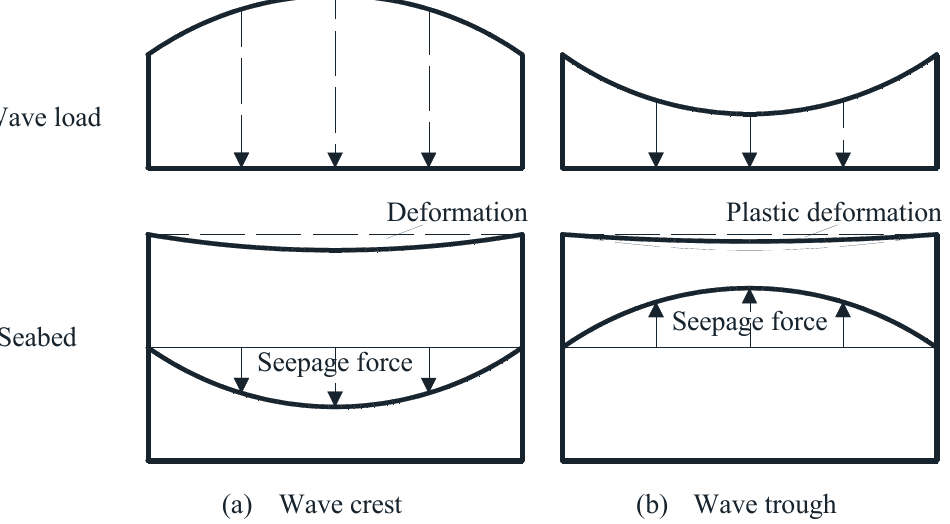
Figure 10. The Schematic diagram of liquefaction mechanism ( a ) is the seabed response at wave crest and ( b ) is the seabed response at wave trough.